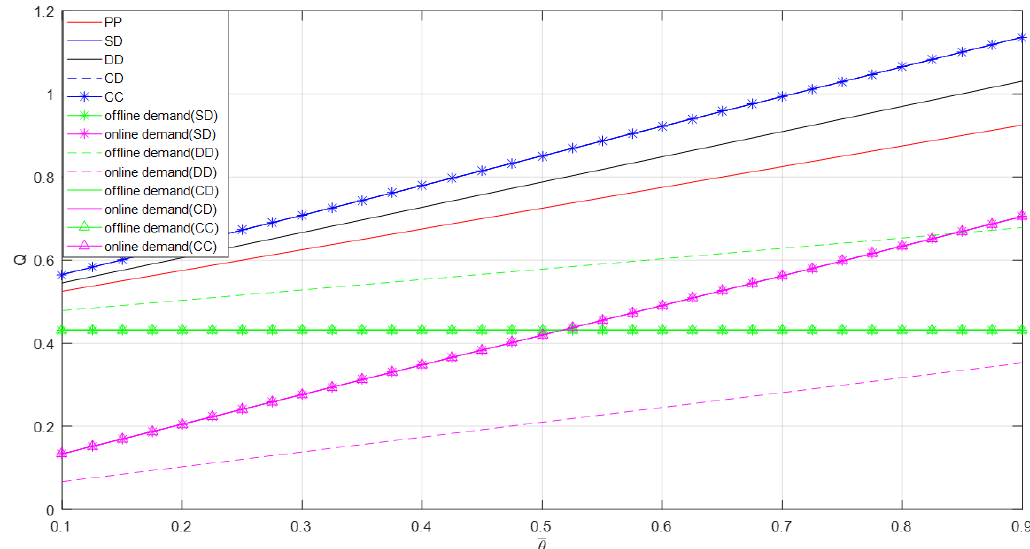
Figure 6. Figure 6.